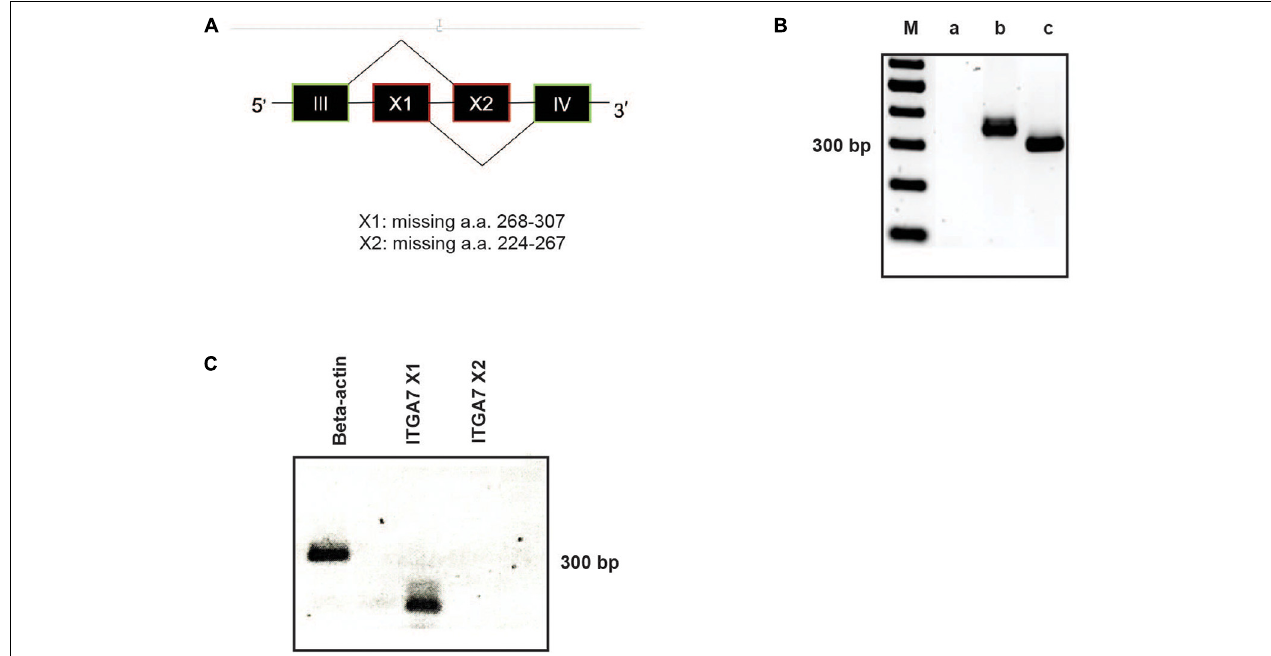
FIGURE 3 | RT-PCR analysis of ITGA7. (A) Schematic drawing of the integrin α 7X1, X2, and X1X2 isoforms. (B) cDNA of isolated CD34 + HSPC was amplified with a specific primer pair for all integrin α 7 isoforms (amplification product: 358 bp; lane b). β -actin was amplified as a positive control (317 bp; lane c). Lane a: water control, lane M: 100 bp ladder. (C) Using primer pairs specific for the ITGA7 isoform X1 (amplification product: 144 bp) and X2 (232 bp) revealed that CD34 + HSPC transcribe only mRNA for the X1 isoform, no signal for X2 could be detected.